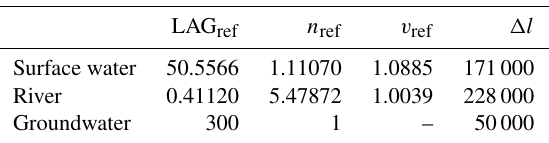
Table 3. Reference values for lateral water flow computation ob- tained from sensitivity simulations described in Hagemann and Dü- menil